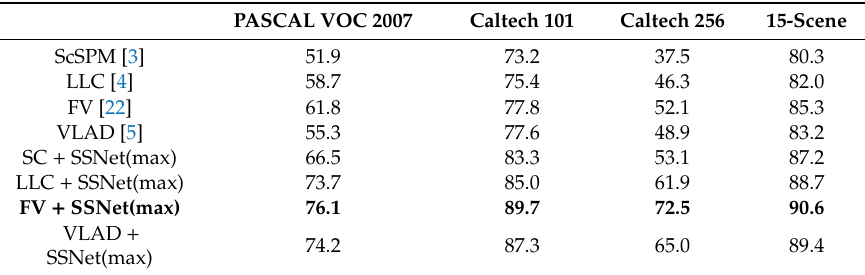
Table 2. Classification accuracy (MAP in percentage) of the SSNet framework integrating with di ff erent BoVW